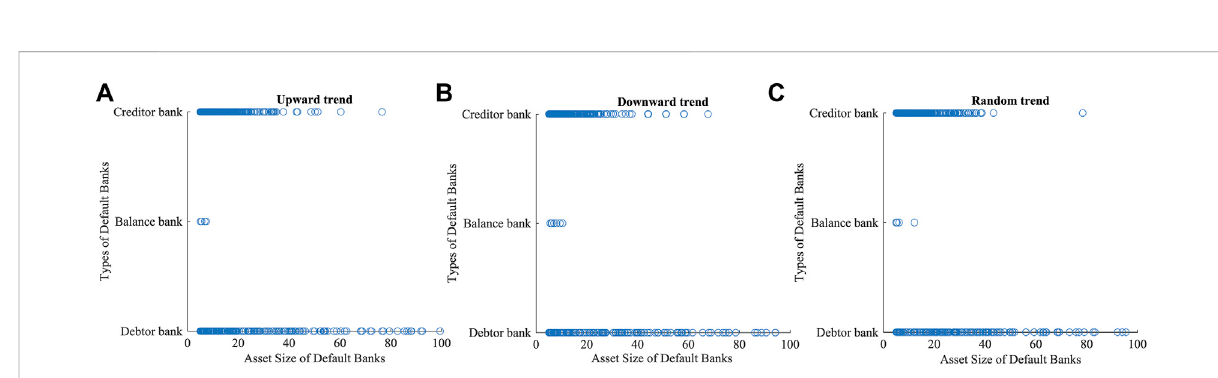
FIGURE 6 Asset size and the types of interbank lending of default banks when the macroeconomic fl uctuations in upward (A) , downward (B) and random (C) trends,